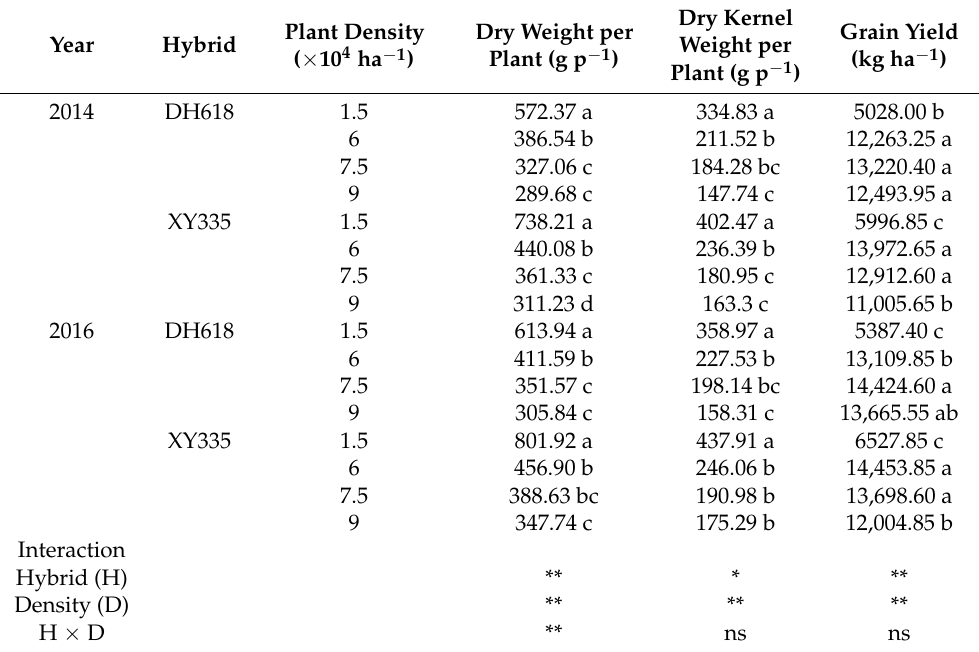
Table 8. Biological yield and grain yield of DH618 and XY335 under different planting densities in 2014 and 2016.